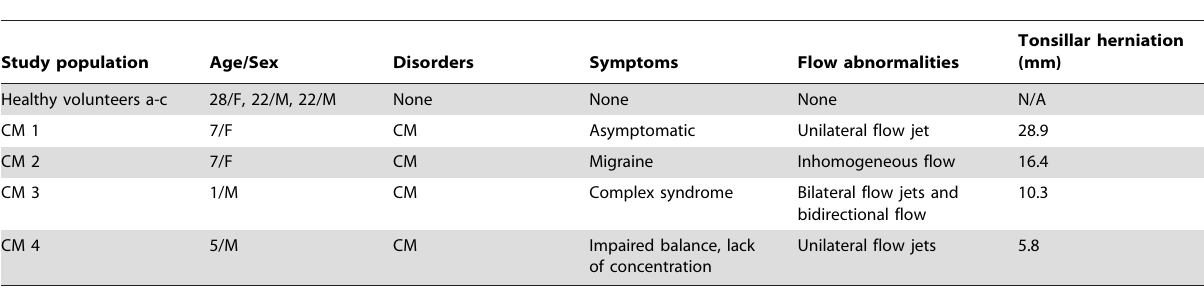
Abbreviations: F=female, M=male, CM=Chiari I malformation. doi:10.1371/journal.pone.0052284.t002 PLOS ONE |